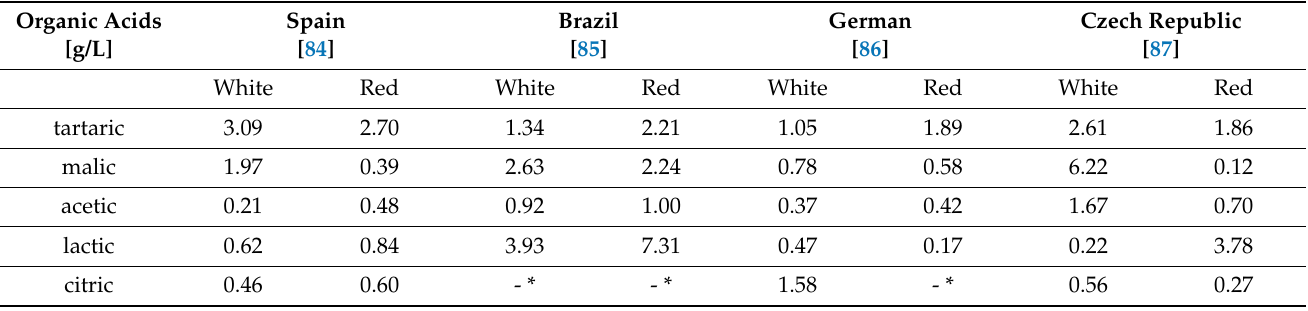
Table 7. Content of organic acids in wines from selected